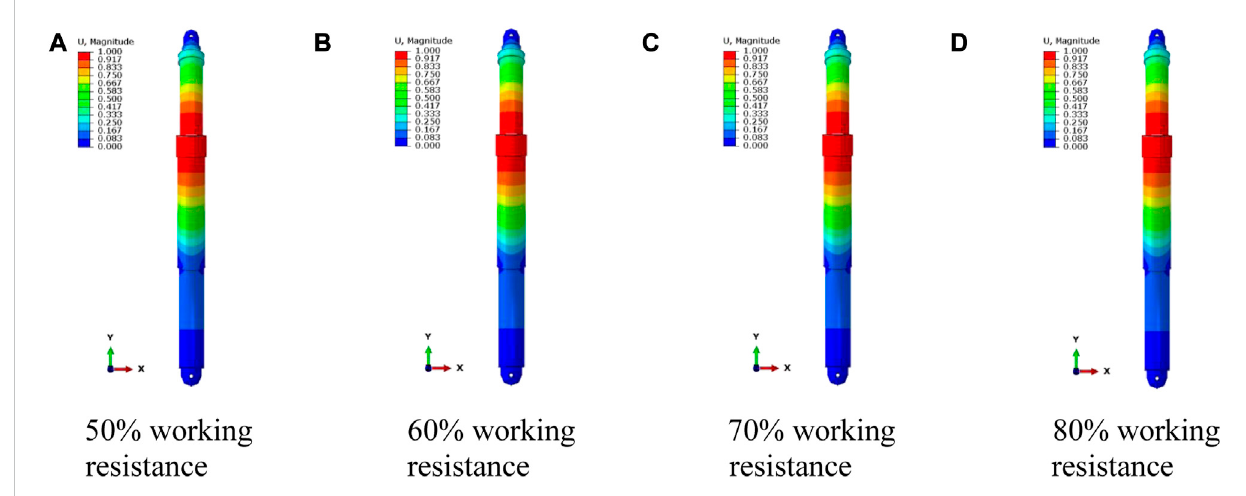
FIGURE 12 1st-order vibration mode of column with different setting forces (A – D) .